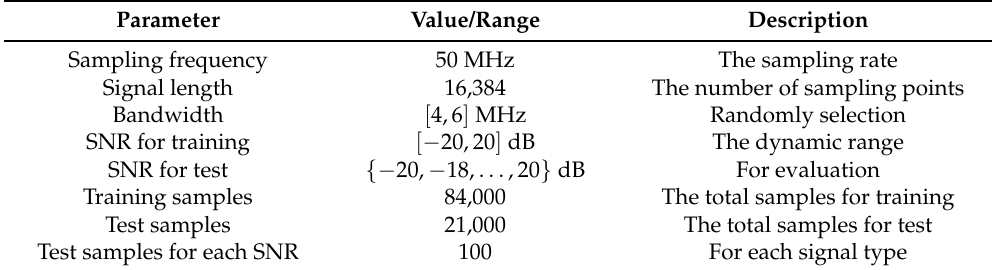
Table 3. Signal parameters.